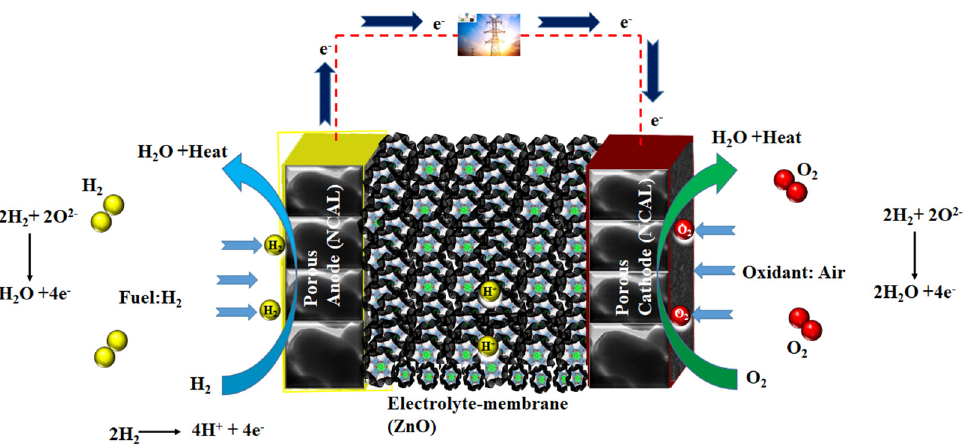
Figure 7. ( a – c ) X-ray photoelectron spectra of the Zn-2p, O1s, and C1s spectra of as − synthesized ZnO powders after fuel cell performance measurements, where different colors represent various peaks of XPS spectra.